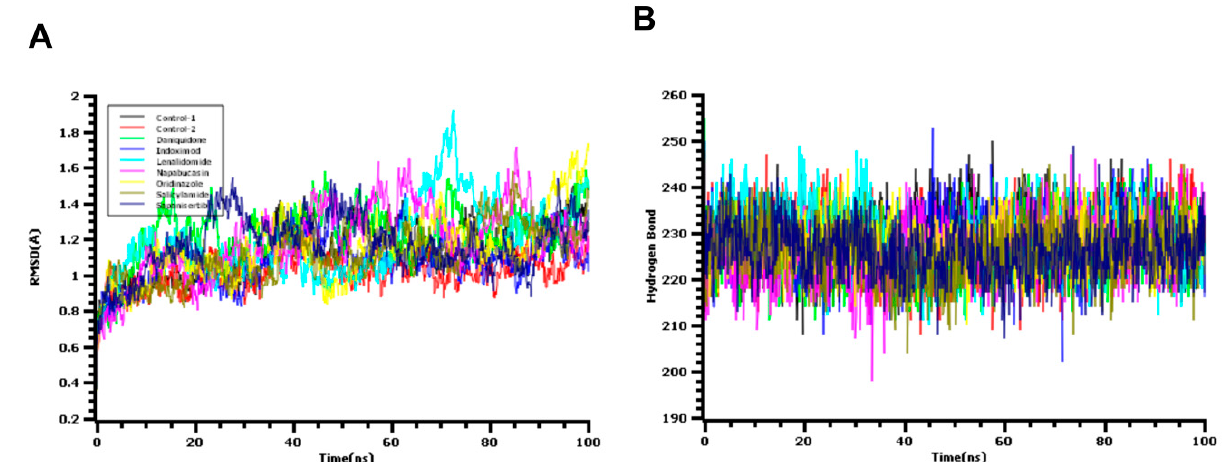
Figure 4. 2D docking interactions of ( A ) Sapanisertib, ( B ) Ornidazole, ( C ) Napabucasin, ( D ) Lenalidomide, ( E ) Daniquidone, ( F ) Indoximod, ( G ) Salicylamide, and ( H ) Control 1 with SARS-CoV-2 M pro (PDB ID: 5R7Y); ( I ) Control 2 with SARS-CoV-2 M pro (PDB ID: 7BQY). The colors indicate the residue type: red-acidic, green- hydrophobic, purple-basic, blue-polar, light gray-other, darker gray-metal atoms. Interactions with the protein are marked with lines between ligand atoms and protein residues: solid pink—H-bonds to the protein backbone, dotted pink-H-bonds to protein side chains, green—pi-pi stacking interactions, orange-pi-cation interactions. Ligand atoms that are exposed to solvent are marked with gray spheres. The protein “pocket” is displayed with a line around the ligand, colored with the color of the nearest protein residue. The gap in the line shows the opening of the pocket.